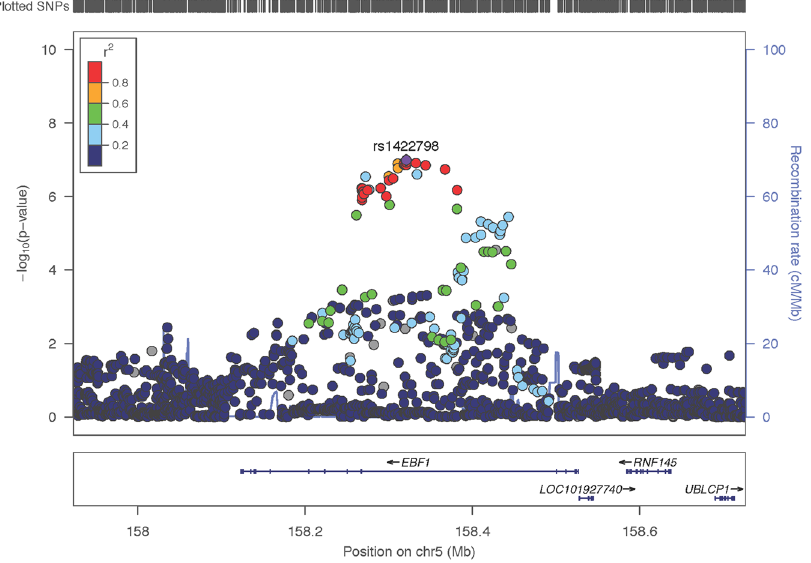
Figure 1. Region of genome-wide nominal association at 5q33.3. Regional plot of the EBF1 -associated interval for the imputation analysis. Foreground shows scatter plot of the − log 10 P values plotted against physical position of human reference hg19. Background shows estimated recombination rates plotted to reflect the local LD structure. The color of the dots represents the strength of LD between the top SNP (rs929626) and its proxies (red, r 2 ≥ 0.8; orange, 0.8 > r 2 ≥ 0.6; green, 0.6 > r 2 ≥ 0.4; blue and navy, r 2 < 0.4). Genes, position of exons, and direction of transcription from UCSC genome browser (http://genome.ucsc.edu) are noted.